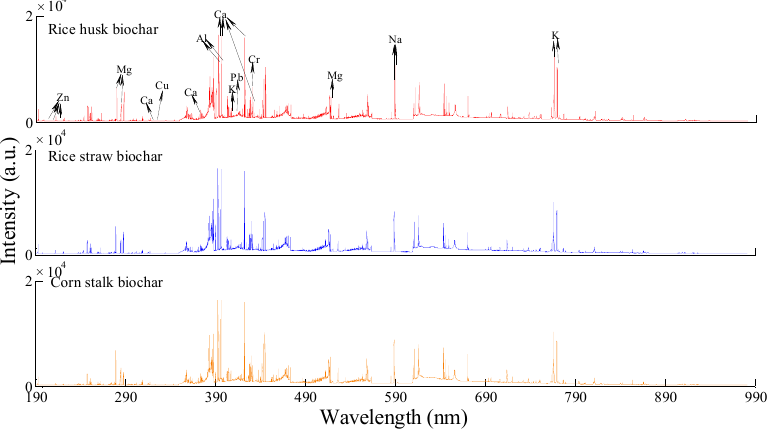
Figure 1. Averaged LIBS spectra of agricultural biochar.